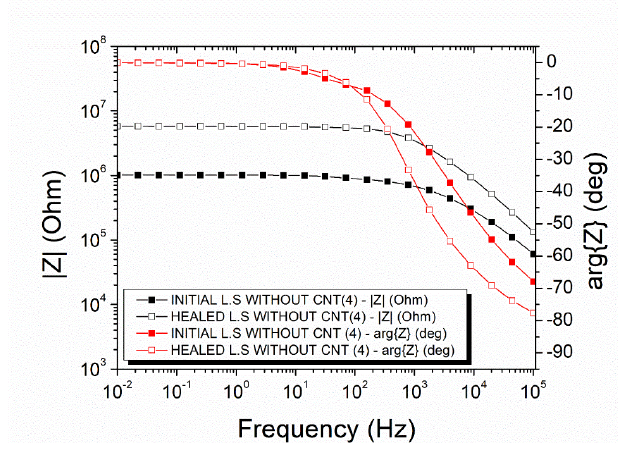
Figure 12. Impedance plots of lap strap specimens with neat micro-capsules.